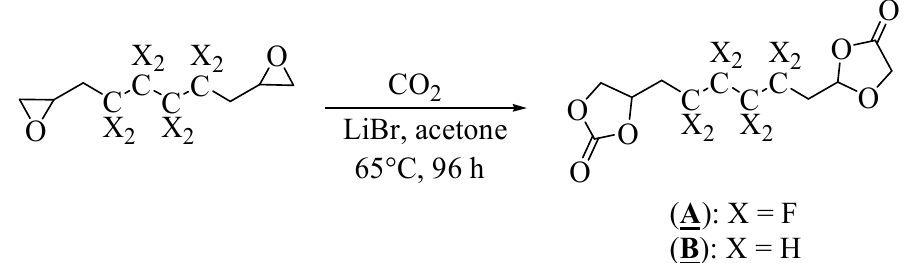
Figure 3. Synthesis of ( A ) and ( B ) by carbonylation of the corresponding diepoxide . After optimization of the reaction conditions, the carbonylation was conducted in a reactor in the presence of acetone at 65 ◦ C for 96 h (Table 1). The fluorinated and non- fluorinated precursors ( A ) and ( B ) were then characterized and confirmed by 1 H, 13 C (and 19 F for A ) NMR spectroscopy (Figures S1–S5 in the Supplementary Materials). Table 1. Syntheses of ( A ) and ( B ) by carbonylation of the corresponding diepoxides a . Entry Diepoxide Yield (%) 1 1 87